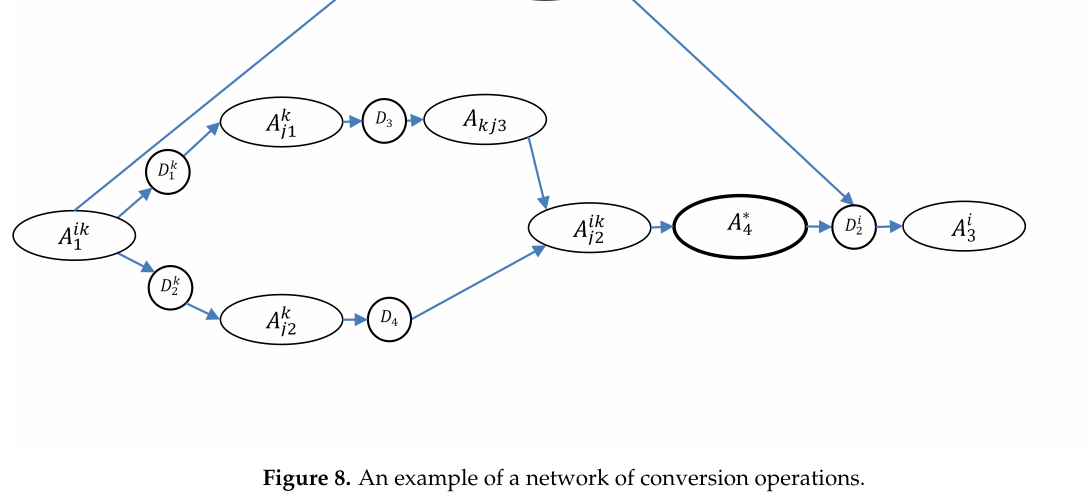
Figure 8. An example of a network of conversion operations.